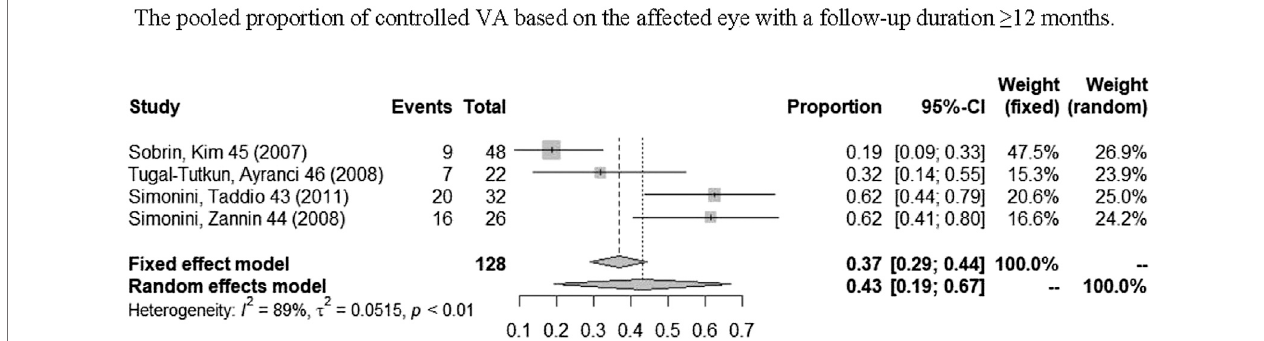
FIGURE 5 | Pooled proportion of controlled VA based on the affected eye with a follow-up duration of ≥ 12 months.